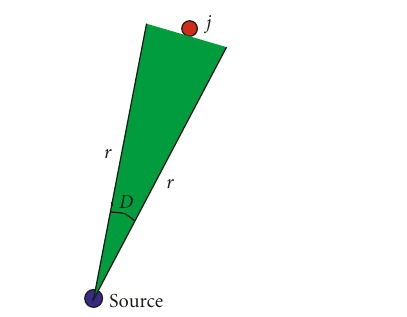
Figure 14: The sector of area r 2 D/ 2 has to contain no nodes for the node j at a distance r from the source to be vwi to the